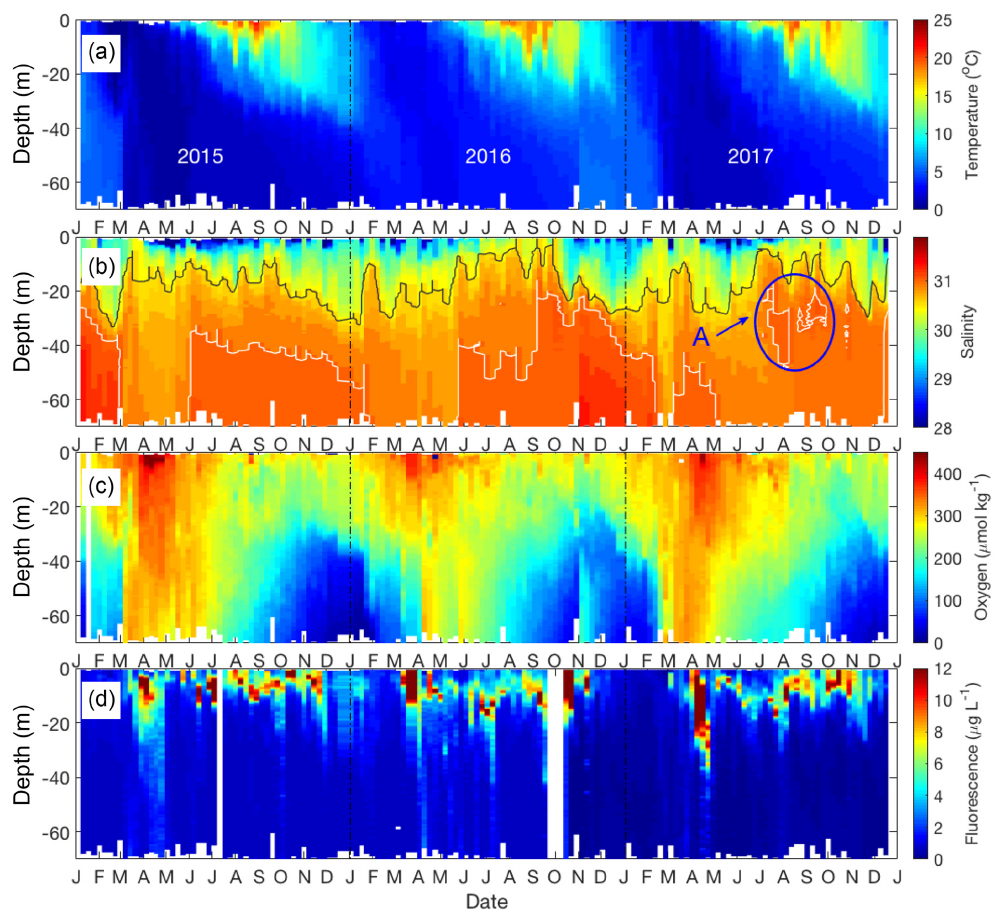
Figure 2. Seasonal patterns of environmental and biological variables in Bedford Basin from January 2015 to December 2017. (a) Tem- perature; (b) salinity (grey contour line for S = 30 . 5; white contour line for S = 31). The blue circle (a) highlights a mid-depth intrusion. (c) Dissolved oxygen; (d) chlorophyll